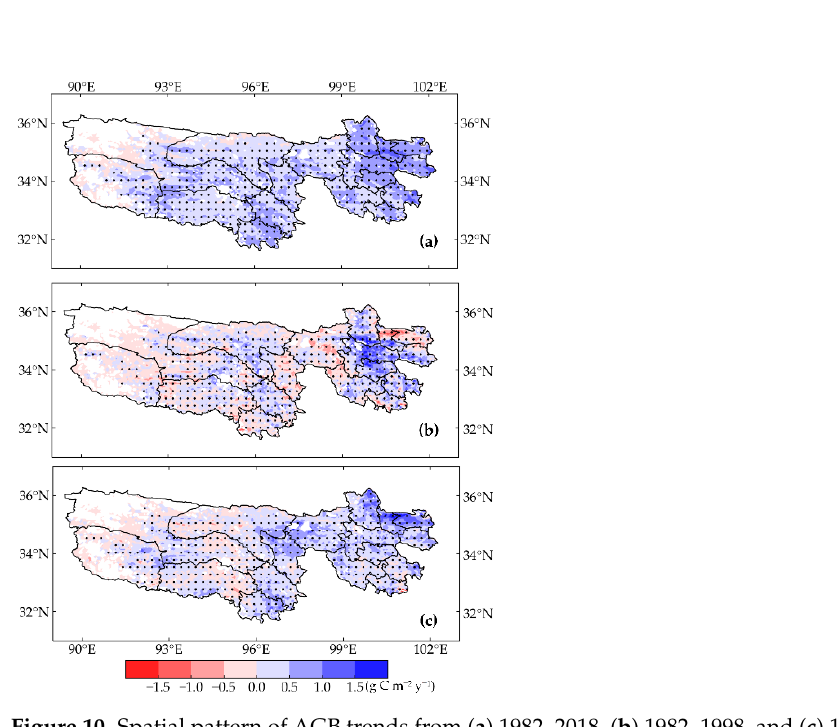
Figure 10. Spatial pattern of AGB trends from ( a ) 1982–2018, ( b ) 1982–1998, and ( c ) 1998–2018 in the TRHR. The black solid dots refer to grids with 95% confidence.